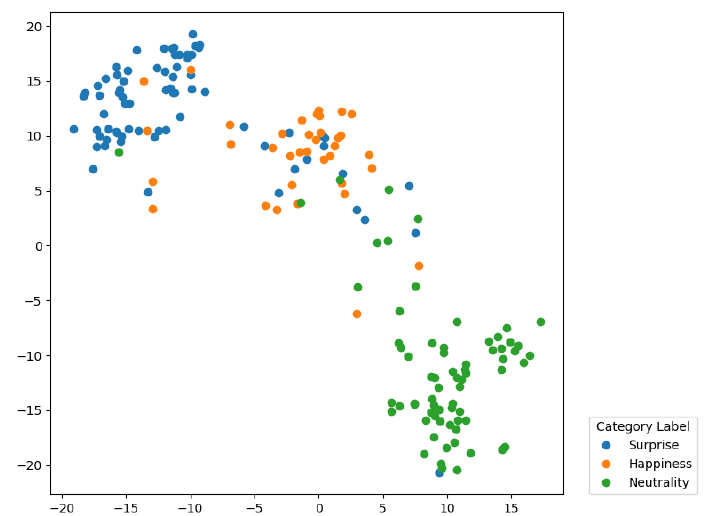
Figure 11. Visualization of distributions of deep emotion features of the model with CMED.